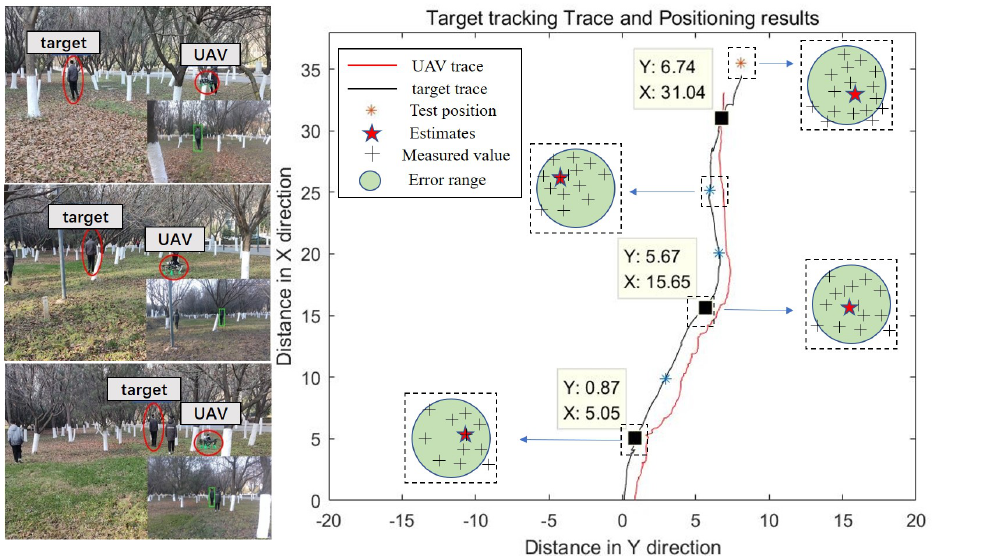
Figure 14. Target tracking Trace and Position